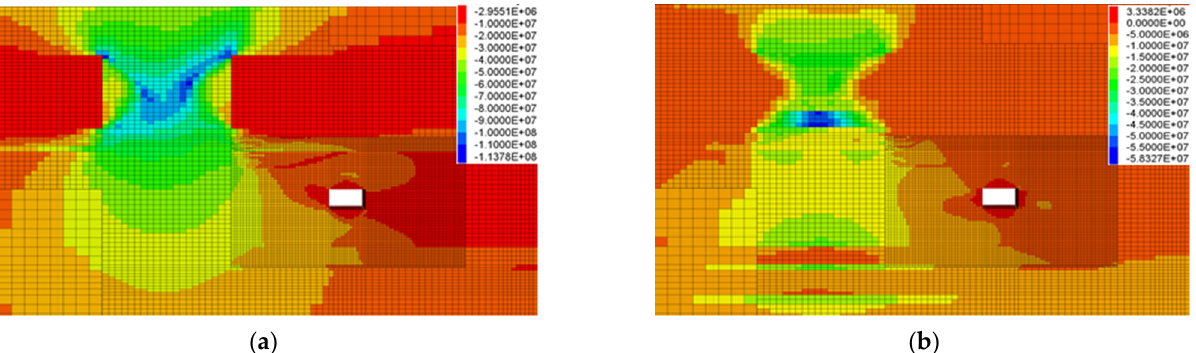
Figure 9. Principal stress distribution contour of the roadway’s surrounding rock when the roadway excavation leaves top coal bottom coal. ( a ) σ 1 cloud. ( b ) σ 3